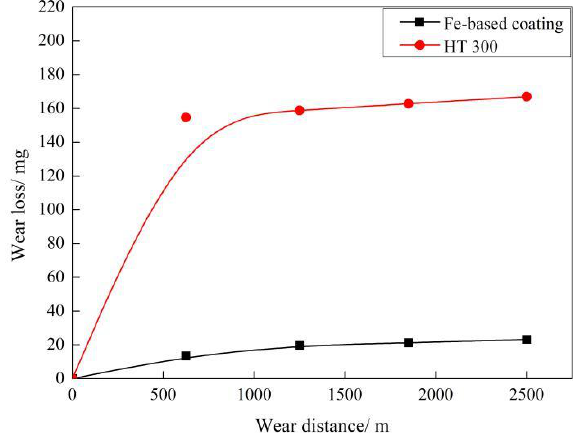
Figure 15. Wear loss of coating and substrate as function of sliding distance at a given load of 100 N.